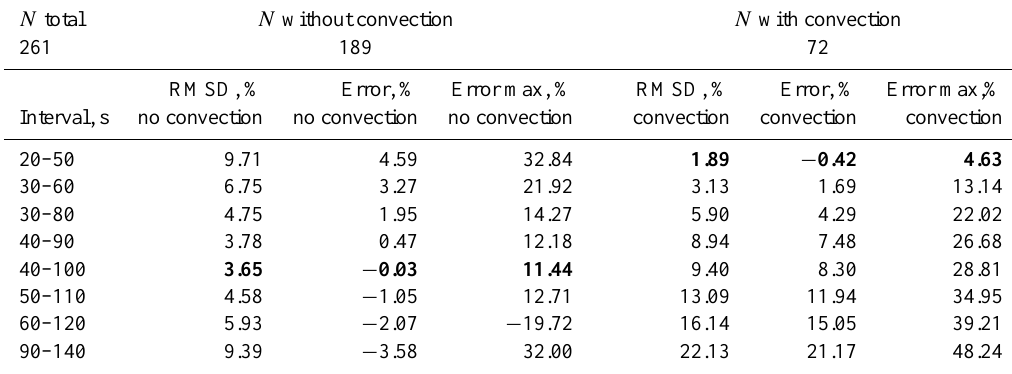
Table 2. Same as Table 1, for the 2013–2014 winter. N